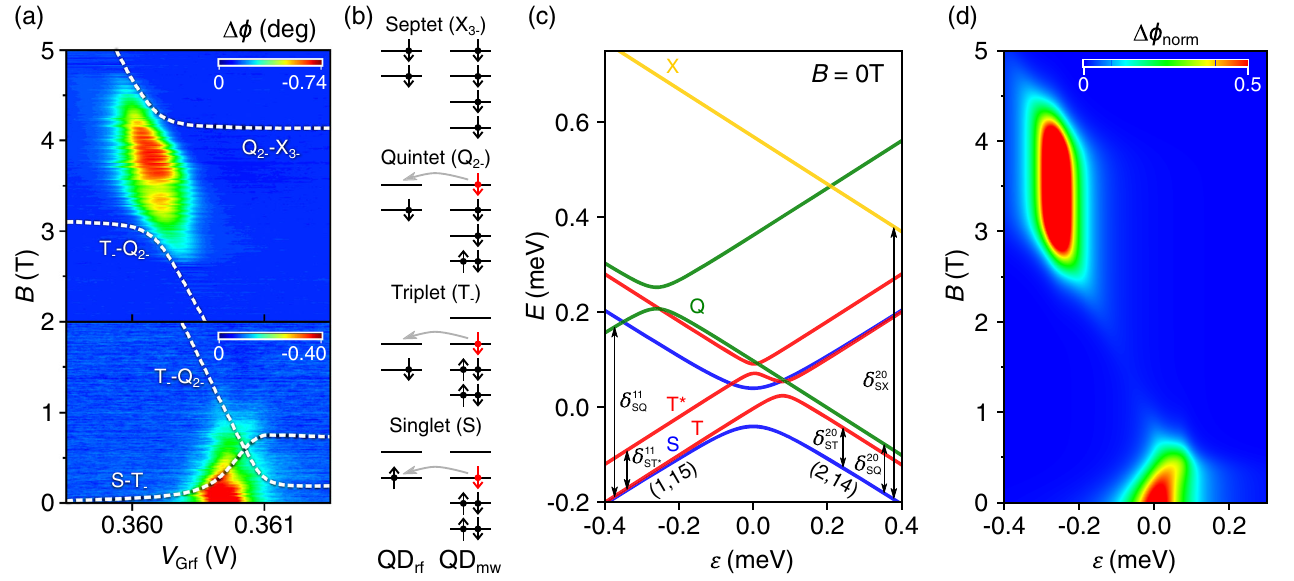
FIG. 2. Pauli spin blockade and energy levels of spin states with S ≤ 3 . (a) Measurement of the (1,15)-(2,14) interdot charge transition ¼ 0 . 440 V as a function of external in-plane magnetic field. From bottom to top, the dashed lines indicate fits to the S-T at V − , Gmw T − -Q 2 − , and Q 2 − -X 3 − energy-level intersection points at varying magnetic fields. (b) Illustrative single-particle energy diagrams of the ¼ 0 ), triplet T ¼ − 1 ), quintet Q ¼ − 2 ), and septet X ¼ − 3 ) states that successively become the ground singlet S ( m − ( m s 2 − ( m s 3 − ( m s s state when increasing the magnetic field in panel (a). For simplicity, the energy diagrams omit the five lowest-lying energy levels of QD . The (1,15)-(2,14) anticrossings of the singlet, triplet, and quintet shown in panel (c) are demonstrated by an electron (in red) mw tunneling from QD to QD . (c) Energy levels of the double quantum dot simulated based on parameters extracted from panel (a) as a mw rf function of (1,15)-(2,14) detuning. The different colors indicate states of varying multiplicity and spin angular momentum S : a singlet with S ¼ 0 (blue), triplets with S ¼ 1 (red), quintets with S ¼ 2 (green), and septets with S ¼ 3 (yellow). The lines with positive slope are (1,15) states, while lines with negative slope are (2,14) states. These states mix near the anticrossings due to (1,15)-(2,14) interdot tunneling. (d) Normalized phase response as a function of magnetic field simulated based on the energy levels presented in panel (c). In order to enhance the visibility of low-field features, the z scale is limited to half of the normalized phase